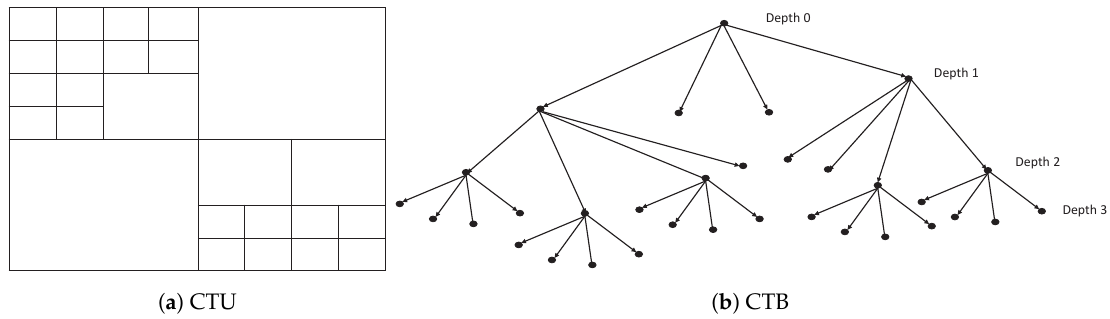
Figure 2. coding tree unit (CTU) partitioning and coding tree block (CTB)